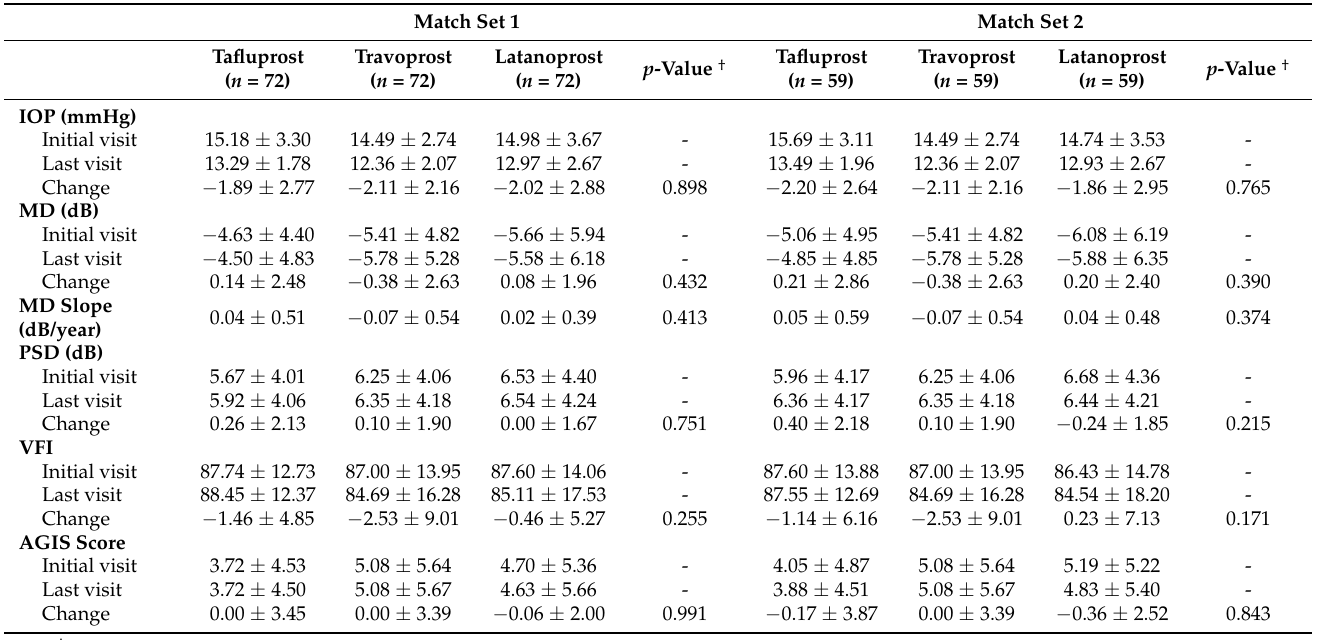
Table 2. Comparisons of endpoint change between the three PGAs in patients with POAG or NTG patients (Match Set 1) and NTG patients only (Match Set 2). All data are presented as mean ± standard deviation.